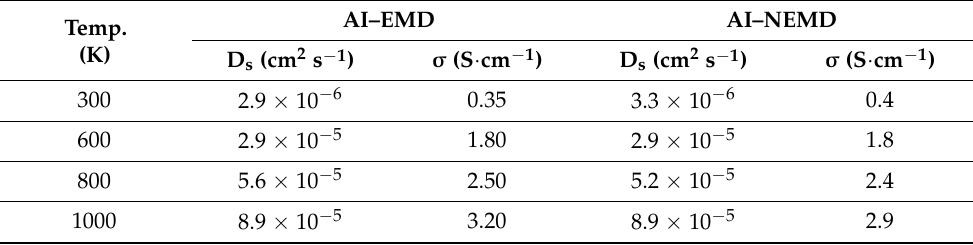
Table 3. Computation using AI–EMD and AI–NEMD simulations for self-diffusion coefficient with concurrent conductivity of Li 5 PS 4 Cl 2 at specific